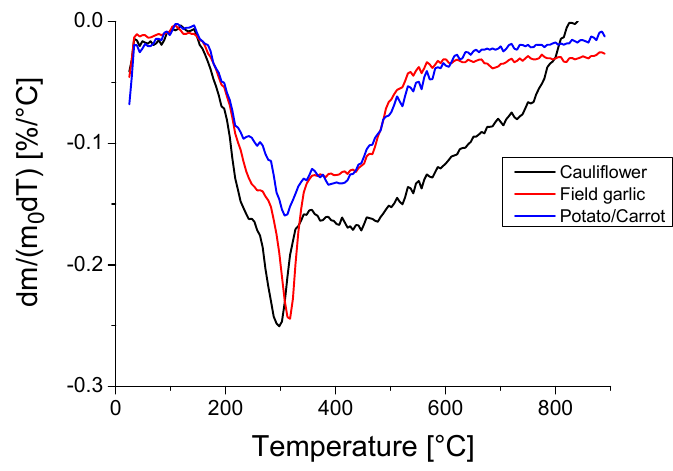
Figure 7. DTG of hydrochar cauliflower, field garlic and potato/carrot mixture (220 °C, 10% dry mass, 4 h). (Modified from [21]).